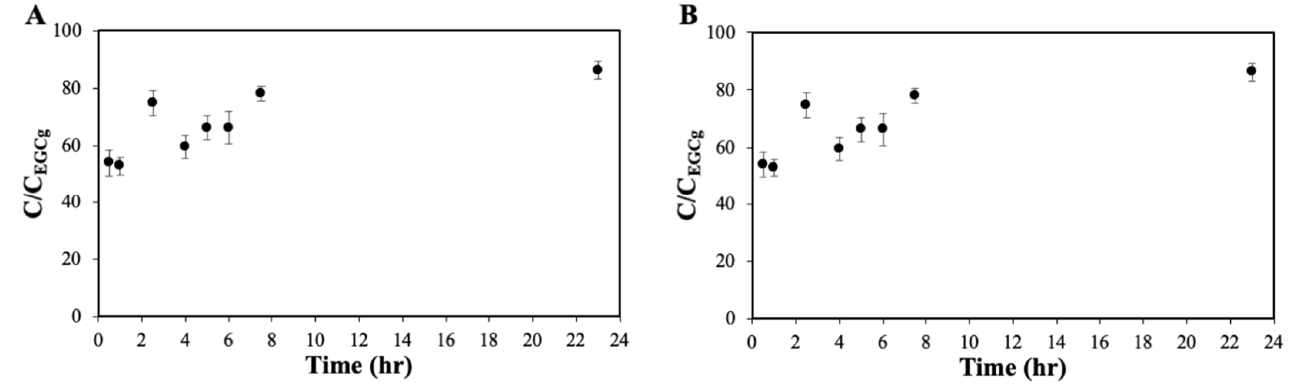
Figure 5. In vitro release profiles of ( A ) EGCG-ChAuNPs and ( B ) EGCG-CystAuNPs at pH 7.4 (in PBS 0.01 M) at 37 ◦ C. C EGCG corresponds to the total amount of EGCG